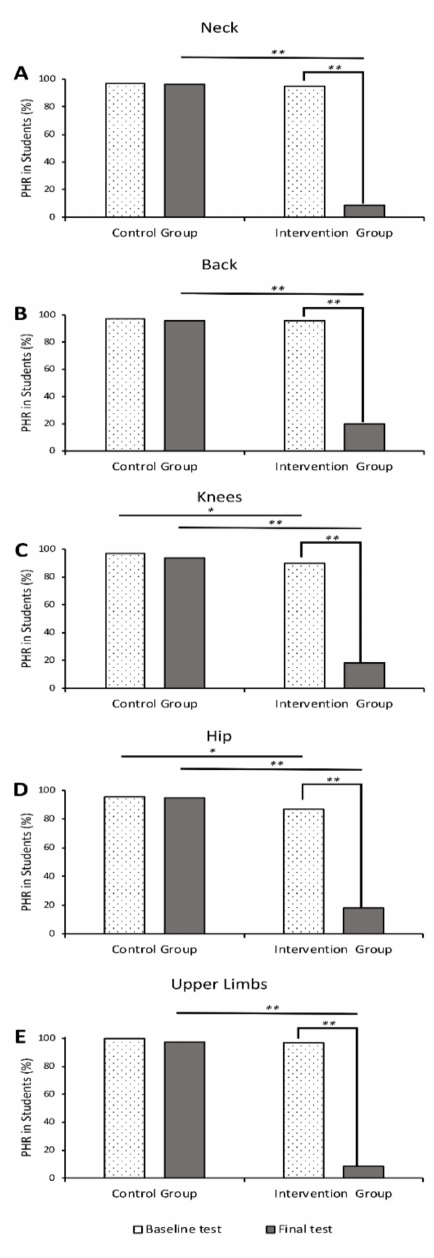
Figure 3. Graphs showing the percentage of students showing potentially harmful responses (PHR) for the di ff erent body parts studied: neck ( A ), back ( B ), knees ( C ), hips ( D ) and upper limbs ( E ). The percentages are shown both for the control and intervention groups. The results for the baseline test are illustrated in the dotted bars, while the results for the final test are shown in the solid grey bars. A chi-squared test was used to evaluate statistical di ff erences. p -values were reported when < 0.05 (*) and < 0.01